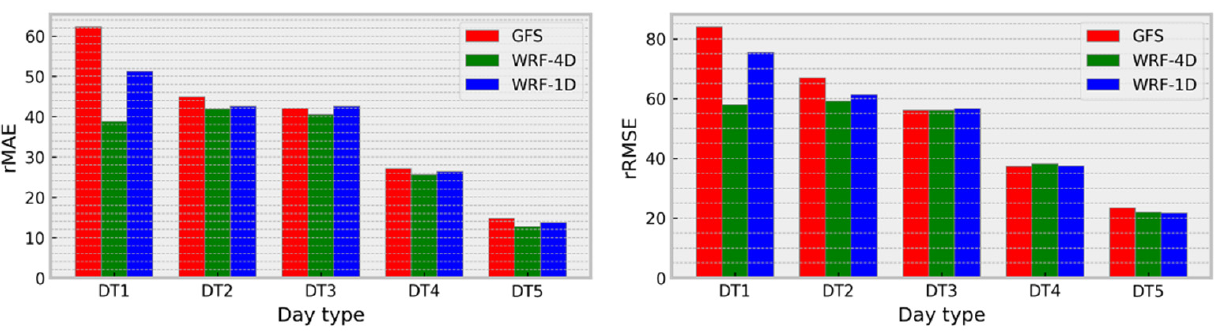
Figure 4. Variation of rMAE and rRMSE for di ff erent day types.